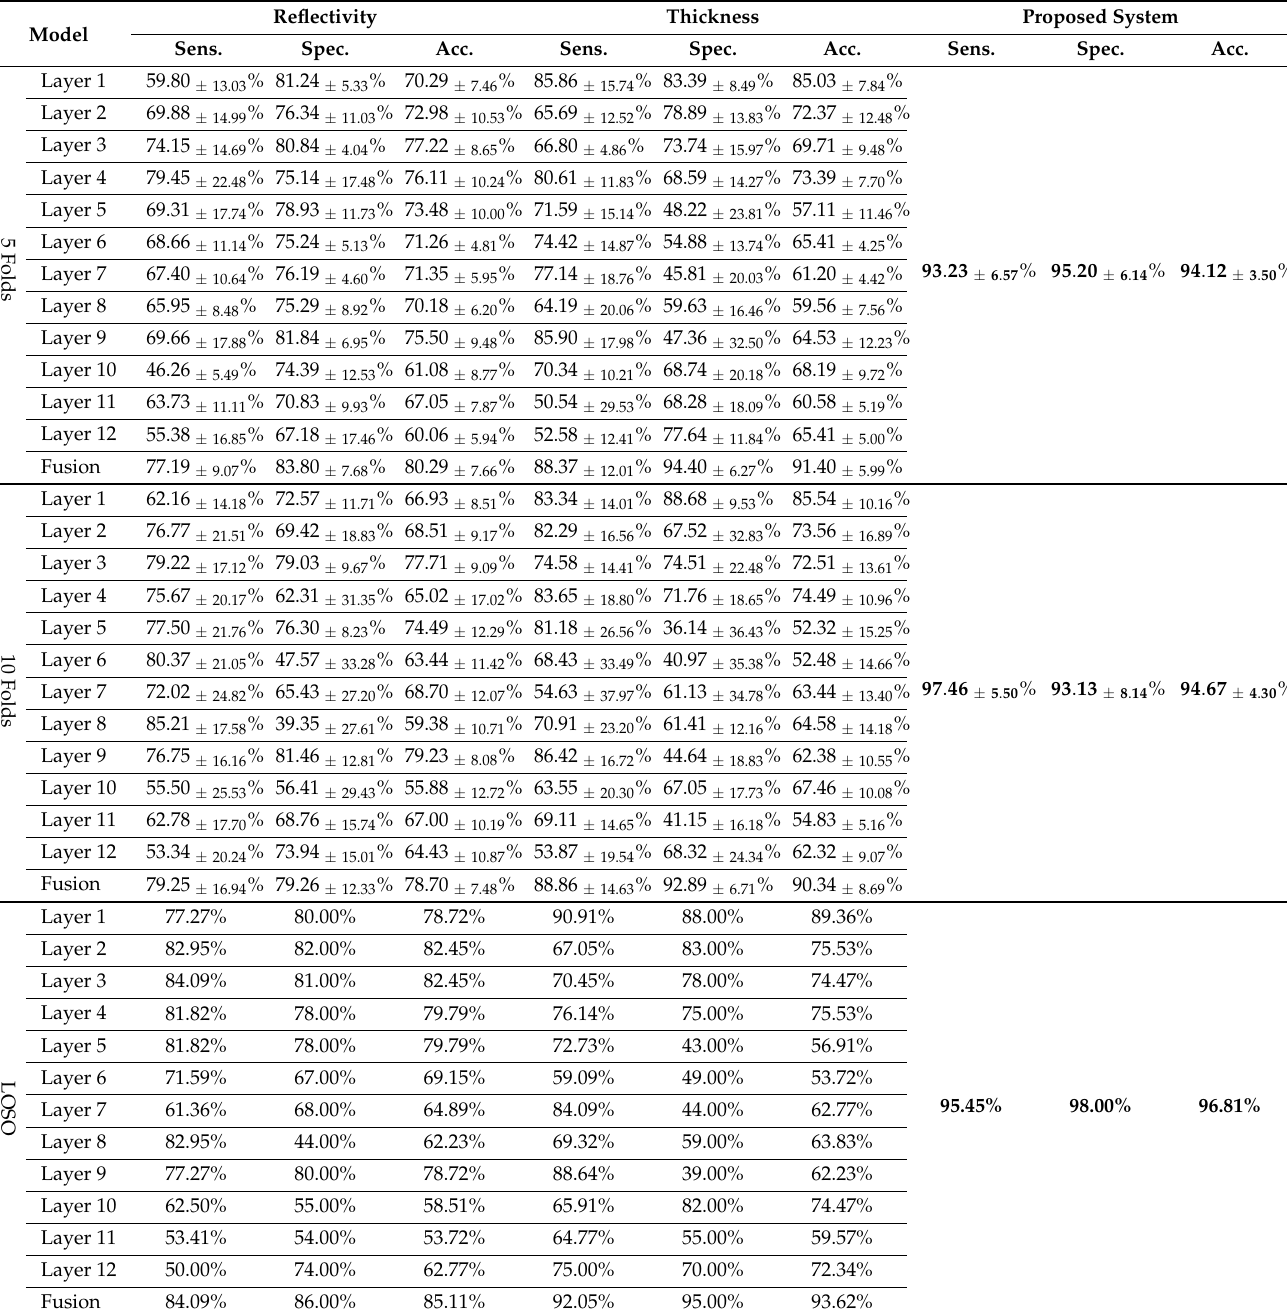
Table 1. Comparison results between the proposed system and other one-feature-based